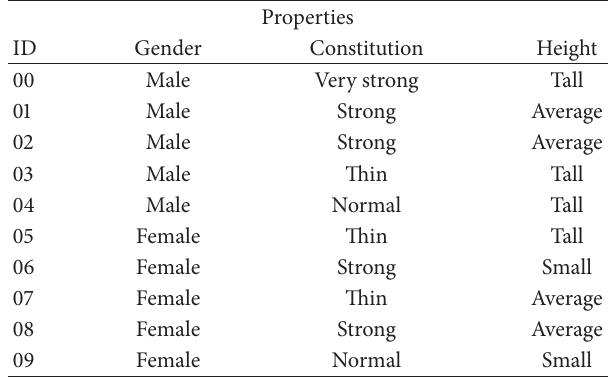
Table 2: Morphological features.